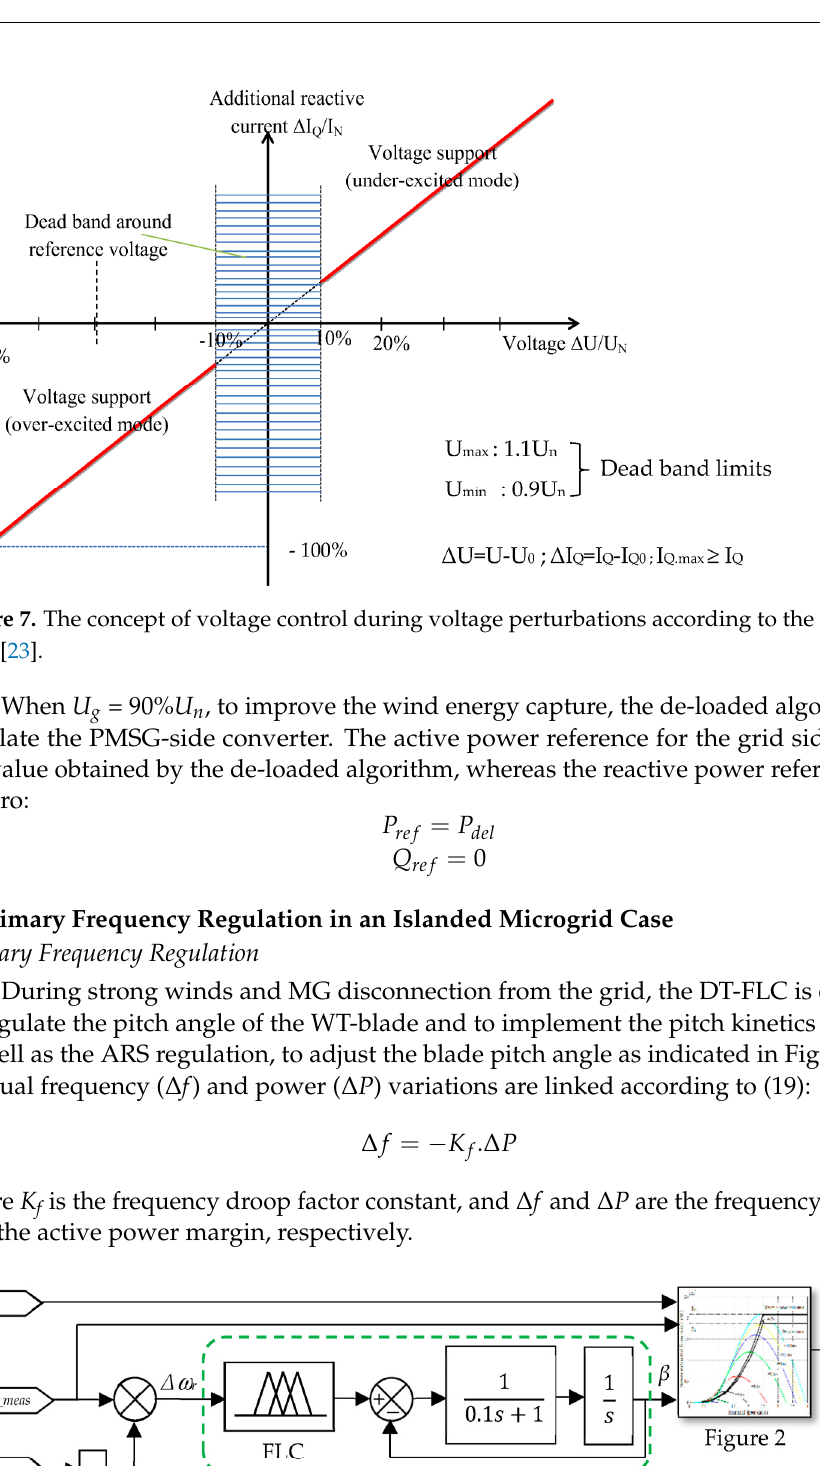
Medium Table 3. PMSG and battery Parameters. Parameters